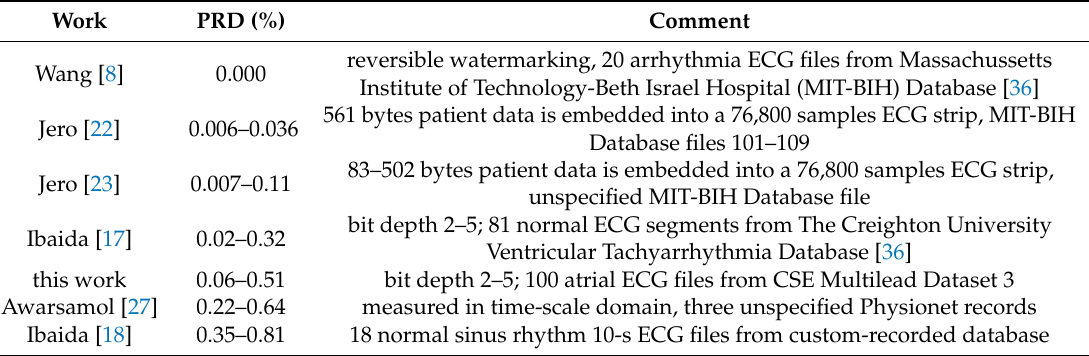
Table 7. Juxtaposition of the watermarking transparency expressed by PRD value for selected